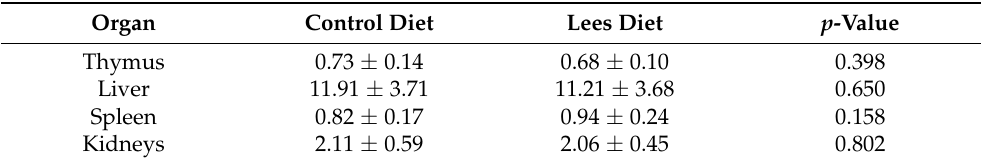
Table 2. Weight (g) of different organs (thymus, liver, spleen, and kidneys) of rats according to diet (control or lees). Values are mean ± standard